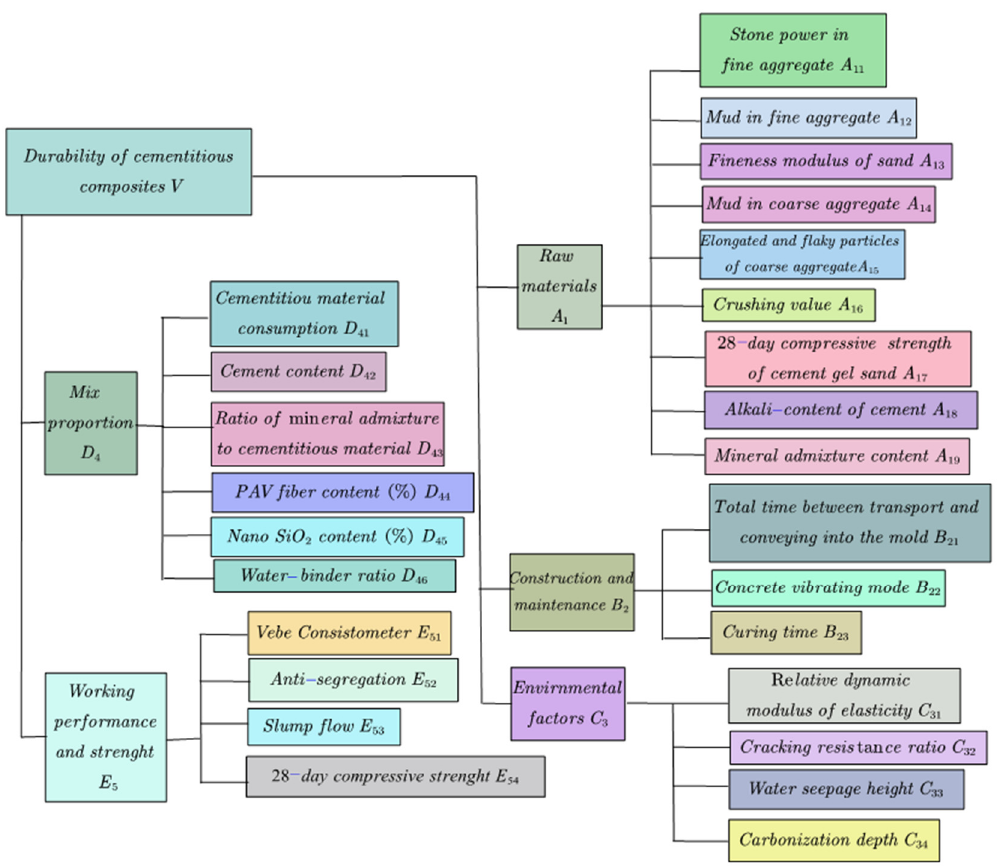
Figure 4. Evaluation index system for the durability of cementitious composite. Table 1. Evaluation indices and grading